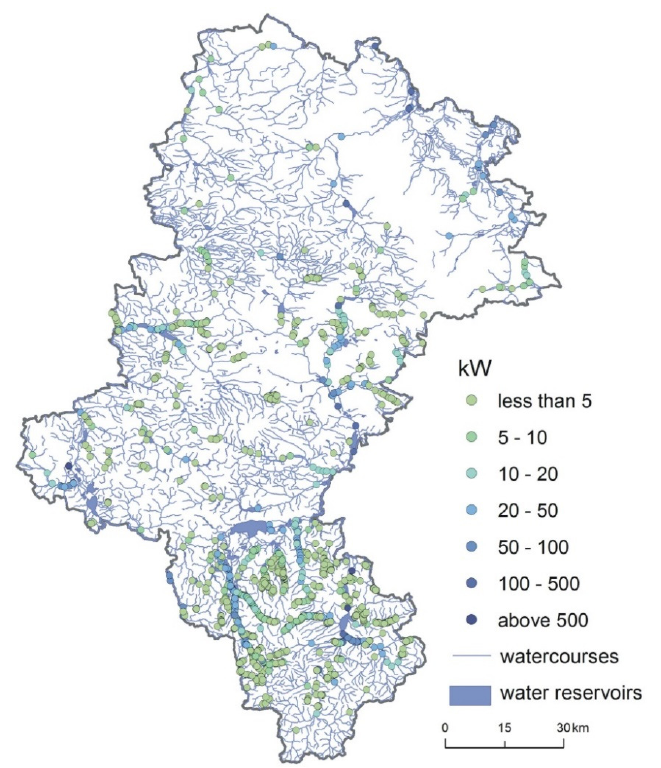
Figure 17. Localization of water dams and power of the potential hydropower plants in the Ś l ą skie voivodeship (own elaboration).